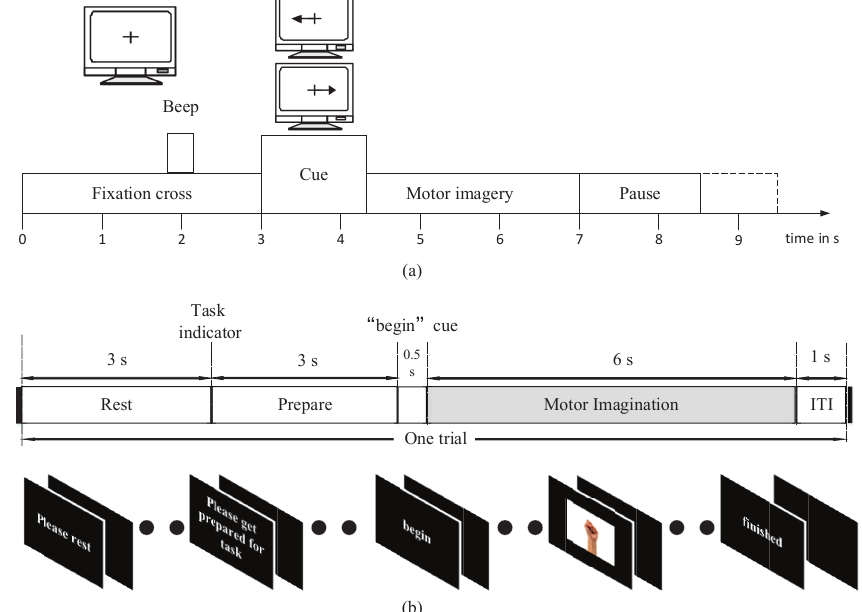
Figure 1. Diagram of a trial and timings during a session of BCI Competition IV dataset 2b ( a ) and our own dataset ( b